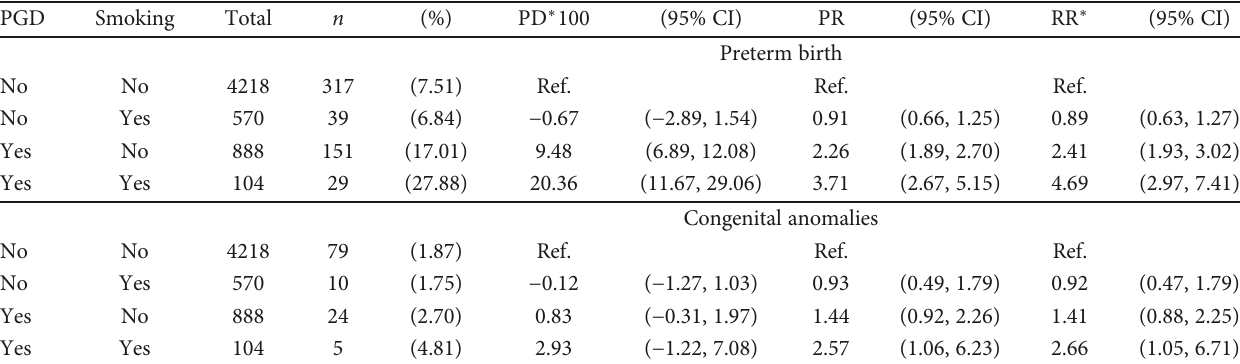
Table 2: Prevalence di ff erence per 100, prevalence ratio and relative risk of preterm birth, and congenital anomalies associated with pregestational diabetes and/or tobacco smoking, Emilia-Romagna region, 2007 –